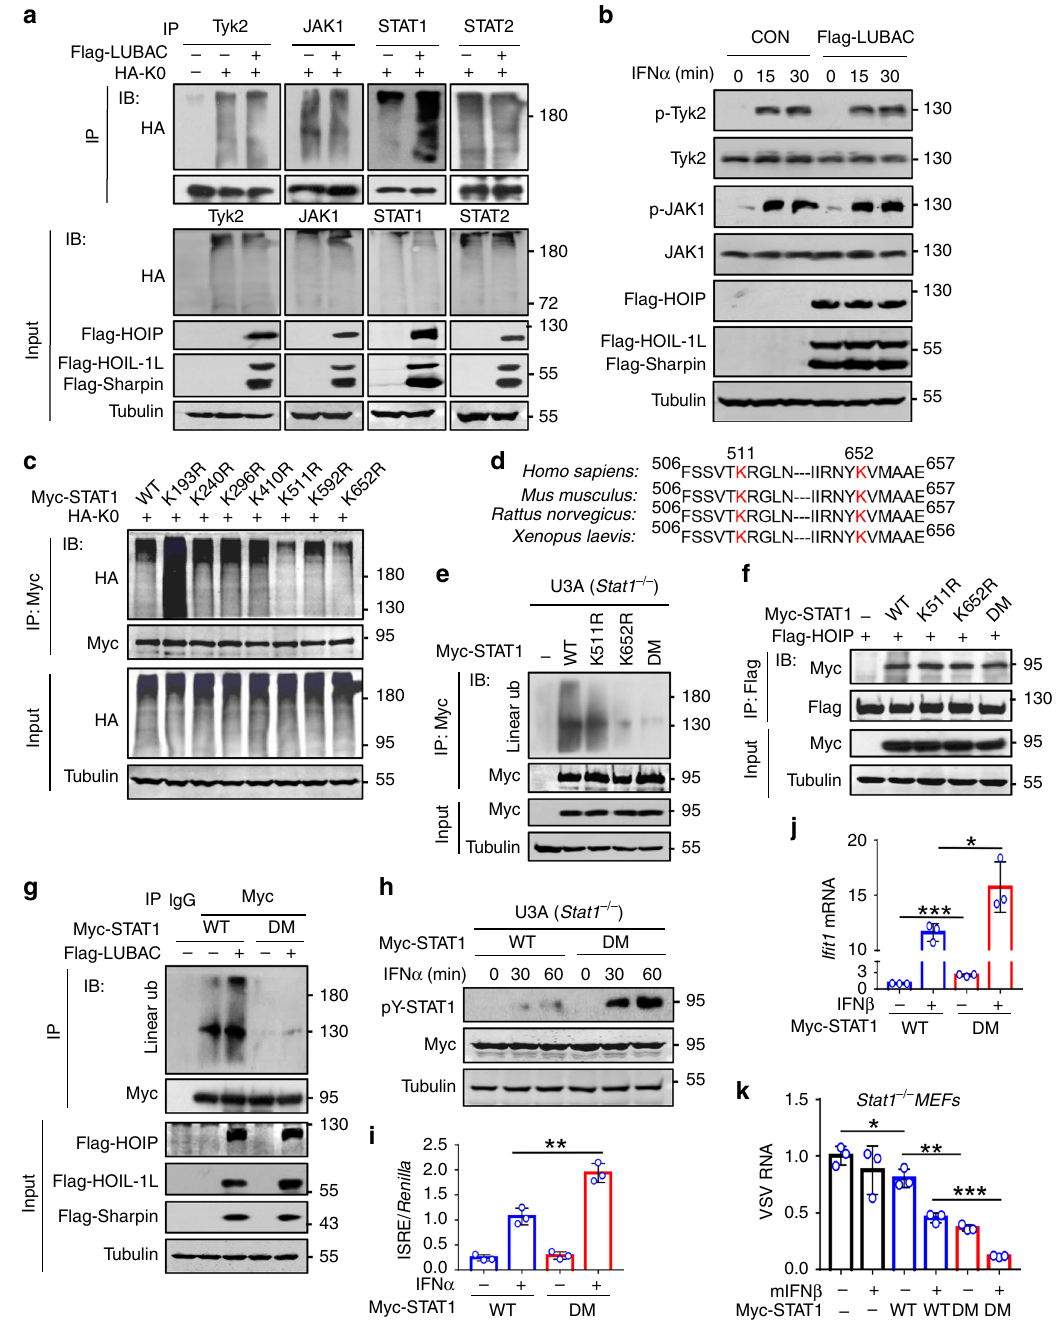
Fig. 3 STAT1 has linear ubiquitination at Lys511 and Lys652. a Immunoprecipitation analysis of ubiquitination of endogenous Tyk2, JAK1, STAT1, and STAT2 in HEK293T cells cotransfected with Flag-LUBAC and HA-Ub-K0 (HA-K0, all lysines on Ub are mutated to arginine) using a HA antibody. b Western blot analysis of the JAK-STAT signaling proteins (p-Tyk2, Tyk2, p-JAK1, and JAK1) in HEK293T cells transfected with Flag-LUBAC and then treated with IFN α (1000 IU/ml) as indicated. c Immunoprecipitation analysis of STAT1 ubiquitination in HEK293T cells cotransfected with Myc-STAT1 (WT or its mutants) and HA-K0. d Highly conserved lysine (K) residues (K511 and K652) on STAT1 from different species. e Immunoprecipitation analysis of linear ubiquitination of STAT1 in U3A ( Stat1 − / − ) cells transfected with Myc-STAT1 (WT), -K511R, -K652R, or -DM (K511/652R). f Immunoprecipitation analysis of the interaction between Flag-HOIP and Myc-STAT1 (WT, K511R, K652R, and DM) in HEK293T cells. g Immunoprecipitation analysis of linear ubiquitination of STAT1 in HEK293T cells cotransfected with Myc-STAT1 (WT or DM) and (or) Flag-LUBAC. h Western blot analysis of pY-STAT1 in U3A cells transfected with Myc-STAT1 (WT or DM) and then treated with IFN α (1000 IU/ml) as indicated. i Dual-luciferase reporter assay of the ISRE activity in HEK293T cells cotransfected with Myc-STAT1 (WT or DM), ISRE luciferase, and Renilla , and then stimulated with IFN α (1000 IU/ml) for 20 h. j RT-qPCR analysis of I fi t1 mRNA in U3A cells transfected with Myc-STAT1 (WT or DM), and then treated with IFN β (1000 IU/ml) for 4 h. k RT-qPCR analysis of VSV viral RNA in Stat1 − / − MEF cells transfected with Myc-STAT1 (WT or DM), and then treated with mIFN β (60 IU/ml) for 20 h, followed by infection with VSV (MOI = 0.1) for 24 h. * p < 0.05, ** p < 0.01, and *** p < 0.001 (two-tailed unpaired Student ’ s t test). Data are shown as mean and s.d. of three biological replicates ( i , j , k ), or are representative of three independent experiments ( a – c , e – h